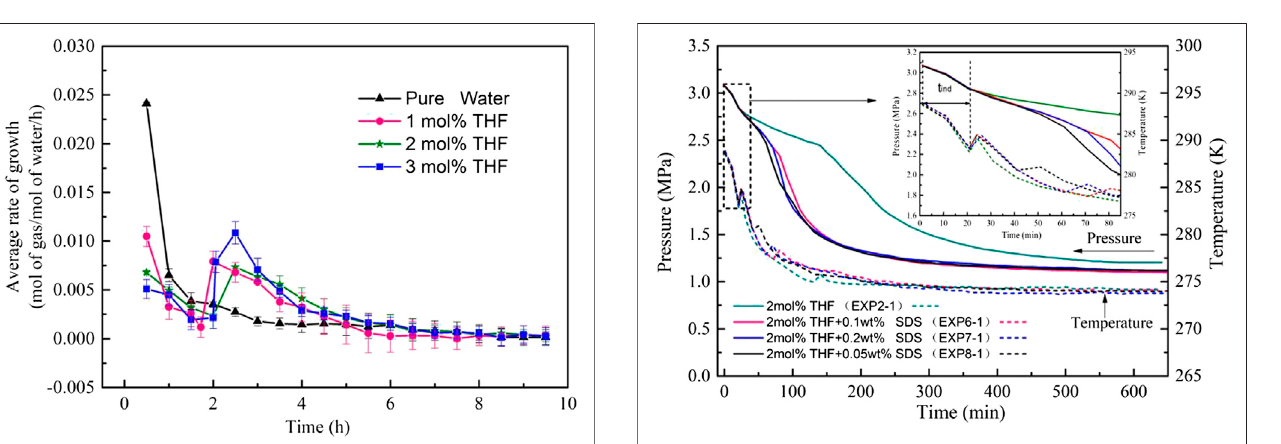
FIGURE 6 | Pressure and temperature evolution of CO 2 hydrate formation with different THF/SDS concentrations at 3.0 MPa.